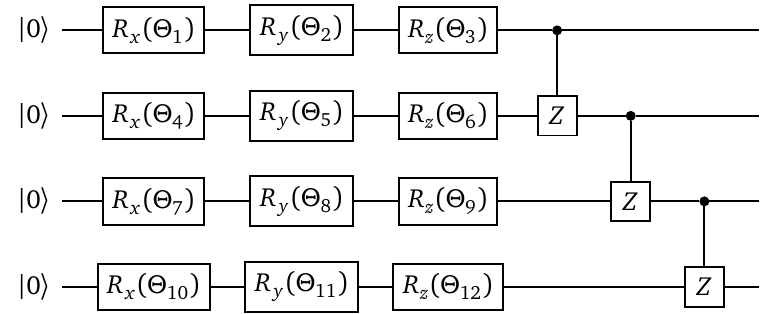
Figure 8: Circuit for four qubits that generate one set of U ized parameters, followed by a series of CNOT gates between the adjacent